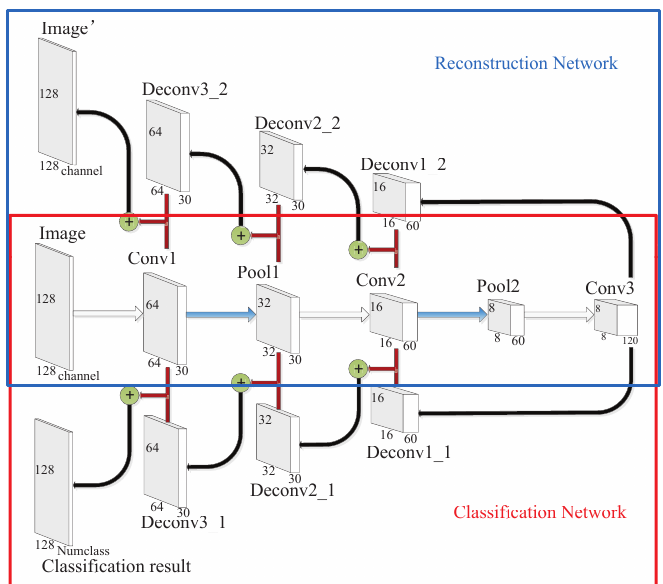
Figure 1. The diagram of RCN, where Conv denotes the convolutional layer, Pool denotes the max pooling layer, Deconv denotes the deconvolutional layer, three color (including white, blue and black) arrows denote the convolution, max pooling, and deconvolution operation, respectively, and “+” represents the add operation. RCN consists of two pipelines: (i) classification network which is indicated by red rectangle, Image and Classification result respectively represent its input and output, and (ii) reconstruction network which is indicated by blue rectangle, Image and Image’ respectively represent its input and output. In addition, the classification network is also the framework of SFCN.